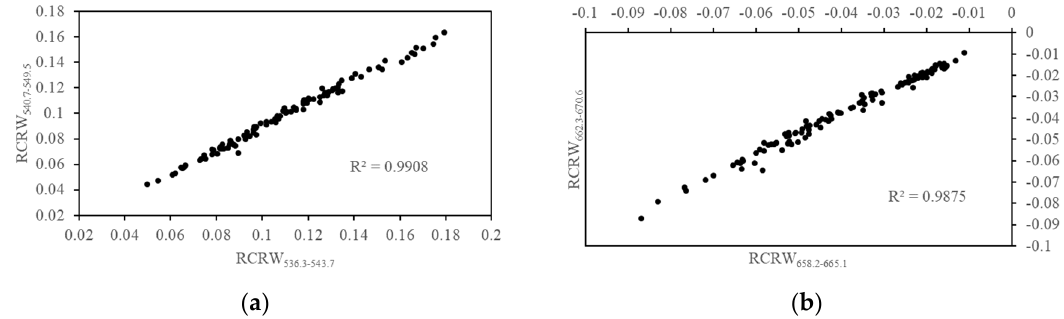
Figure 8. ( a ) The correlation coe ffi cient between RCRW 536.3–543.7 and RCRW 540.7–549.5 ; ( b ) the correlation coe ffi cient between RCRW 658.2–665.1 and RCRW 662.3–670.6